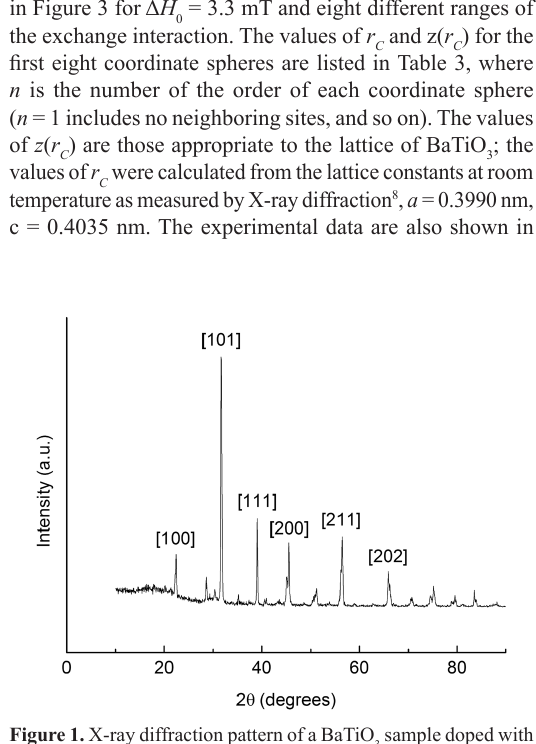
sample doped with 3